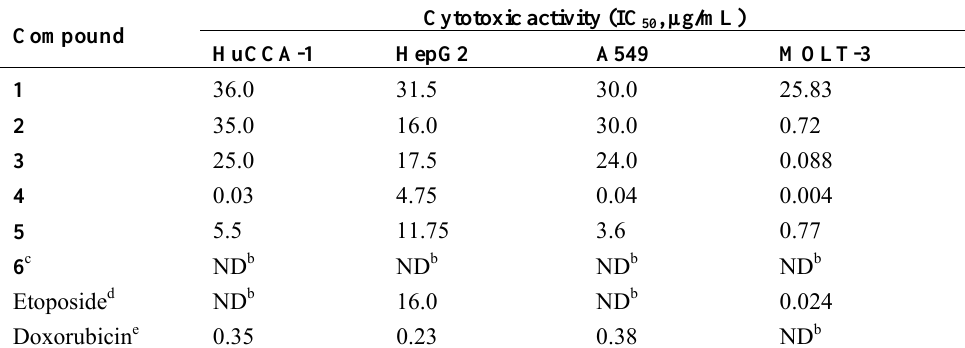
Table 1. Cytotoxic activity a of compounds 1 – 6 against four cancer cell lines.